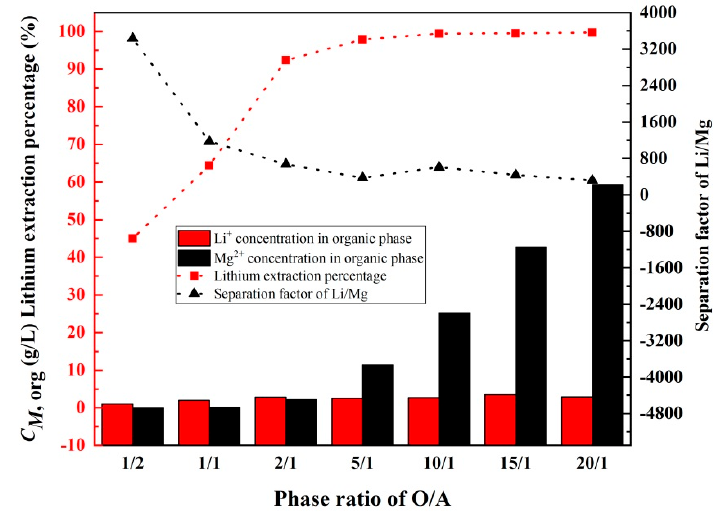
Figure 4. Effect of the phase ratio of O/A.